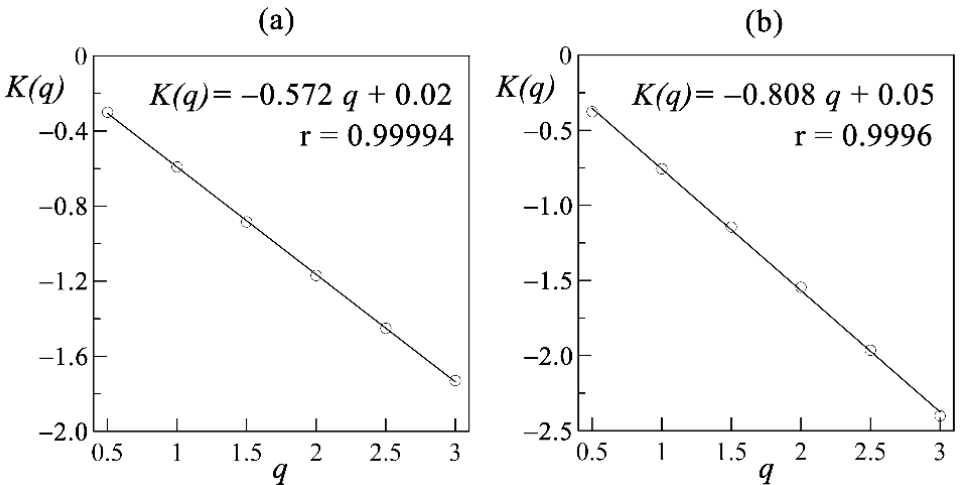
Figure 3. Linear relationship between the scale function K ( q ) and the order- q of the moments for Grazalema ( a ) and the airport of M á laga ( b ). The values of β obtained for the 377 selected series range from − 0.49 at the southern locality of Alcal á de los Gazules (C á diz), to − 0.92 at Pulp í (Almer í a), an extremely